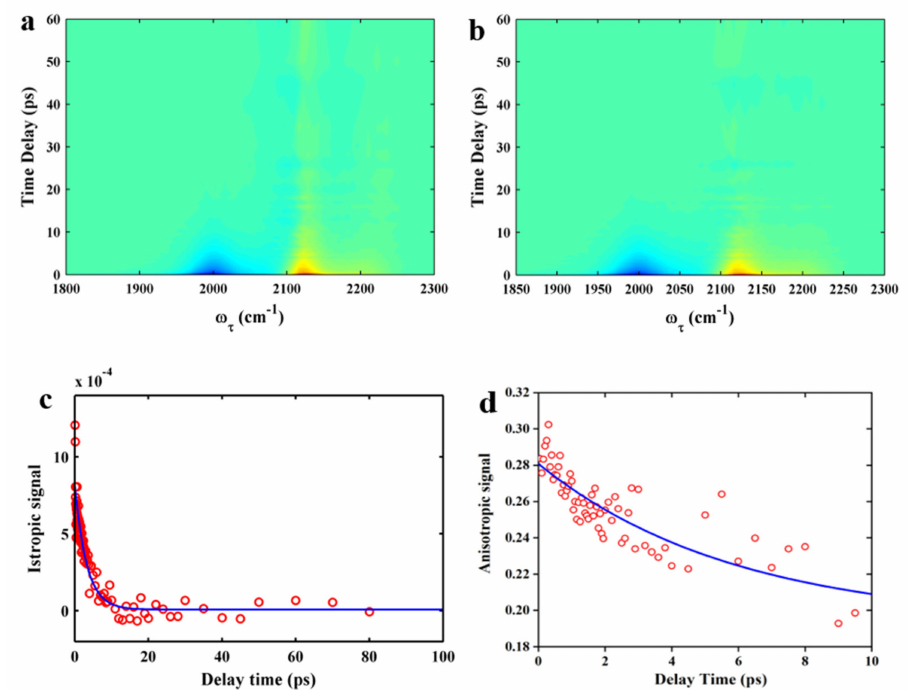
Figure 8. Time- and frequency-resolved isotropic IR pump–probe signals for 5ICI in EtOH before ( a ) and after ( b ) subtraction of the heat contribution. ( c ) Population decay of 5ICI in EtOH. The signal can be fitted to a single exponential function (blue line). ( d ) Anisotropy decays of 5ICI in EtOH. The signal can be fitted to a single exponential function (blue